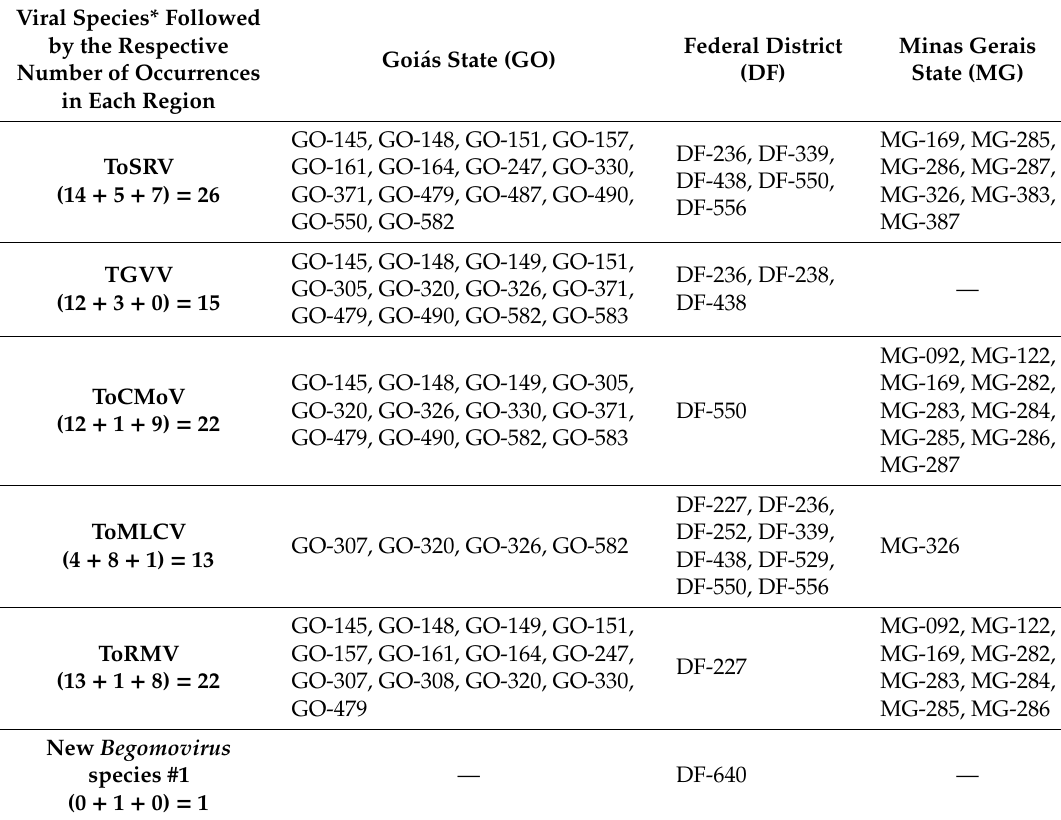
Table 7. Relative frequency of Begomovirus and other circular single-stranded DNA viruses in association with 43 tomato DNA samples harboring the Ty -1 gene detected after Illumina Hiseq sequencing. Viral Species* Followed by the Respective Number of Occurrences in Each